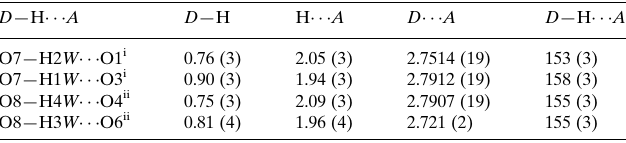
Hydrogen-bond geometry (A˚ , (cid:4)